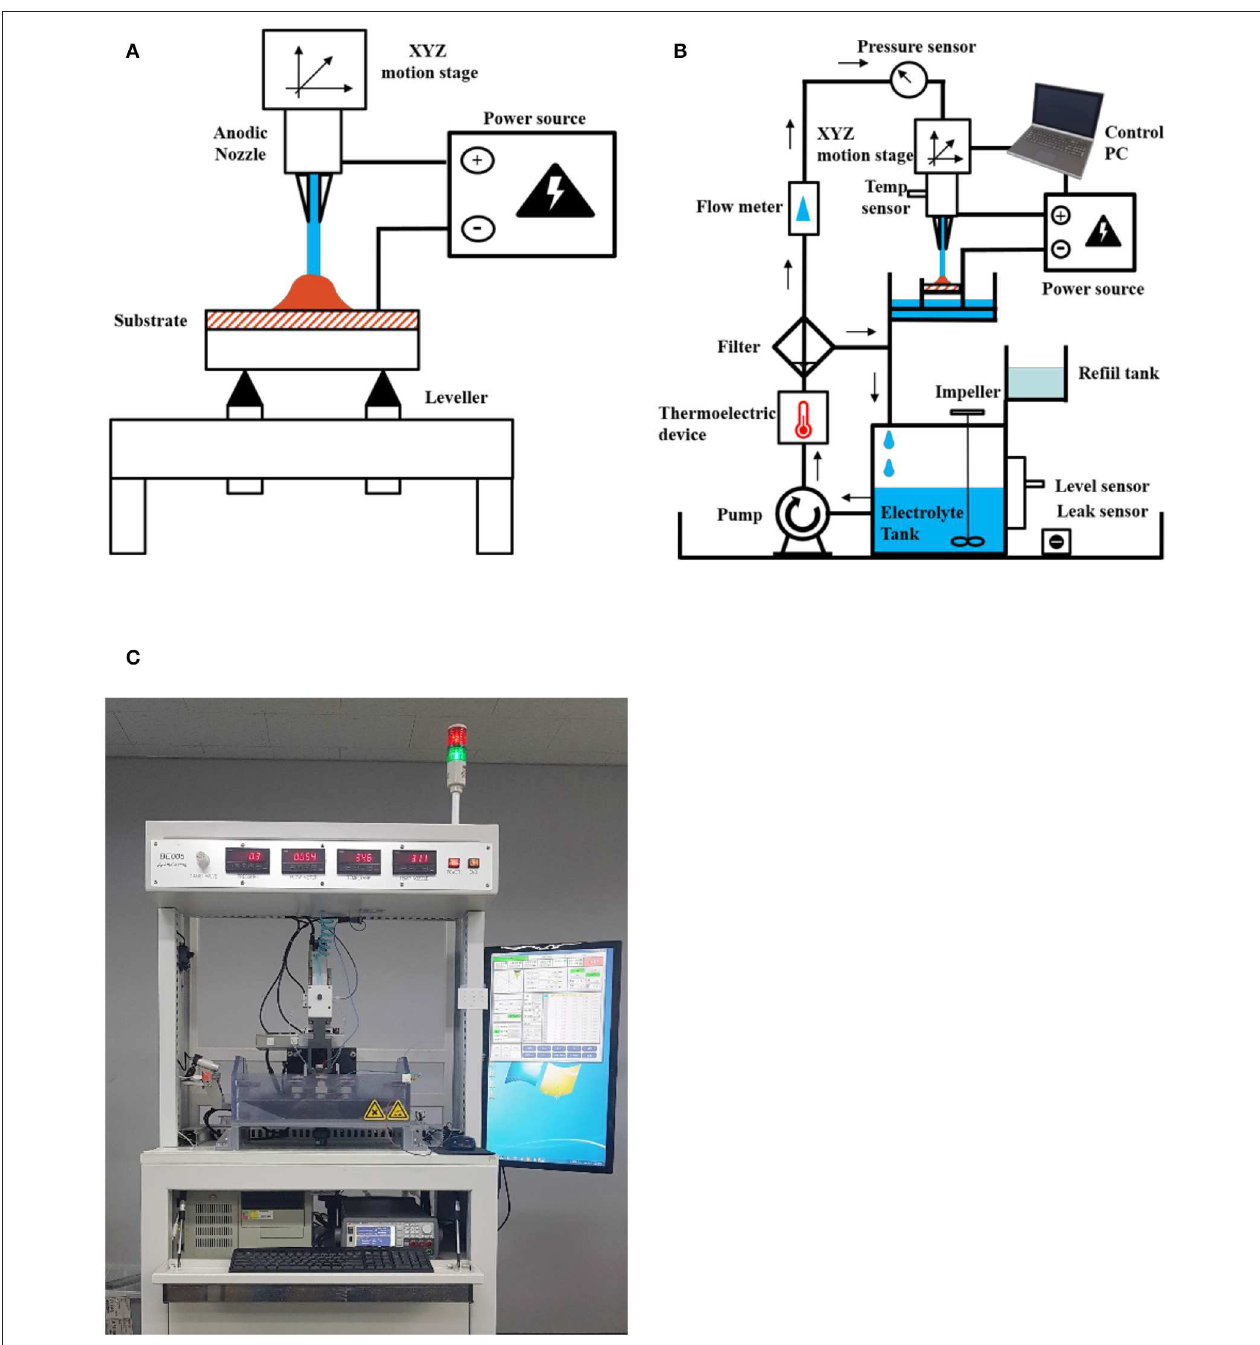
FIGURE 1 | Schematic diagram of the electroplating system, in which the small letters denote the following: (A) concept of 3D printing by the electrochemical method with an electrolyte jet; (B) experimental setup; (C) photo of the actual experimental